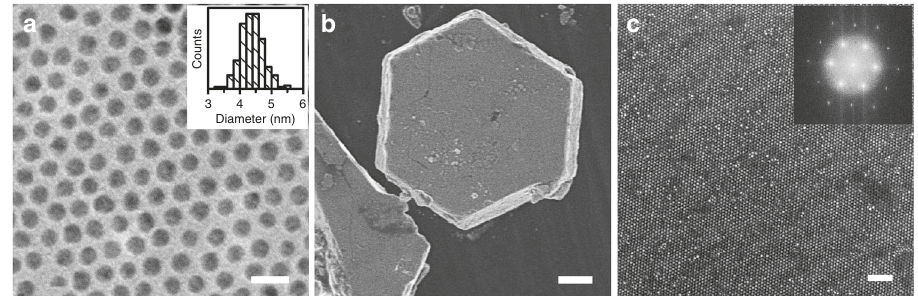
Fig. 1 Electron microscopy characterizations of gold NPs and SCs. a TEM image of the synthesized gold NPs. Scale bar is 10 nm. Inset shows statistics of the particle diameter. b SEM image of a SC. Scale bar is 5 μ m. c High-resolution SEM image of the top surface of the SC showing hexagonal packing. Scale bar is 50 nm. Inset shows the corresponding FFT